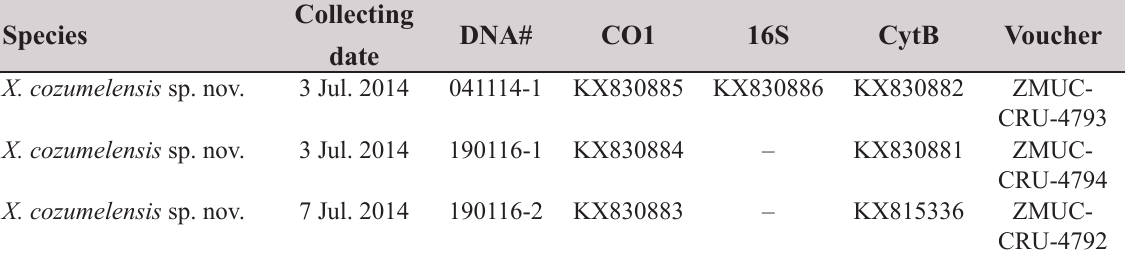
Table 1. Data for the three specimens of Xibalbanus cozumelensis sp. nov. from Cueva Quebrada (Cozumel) sequenced in